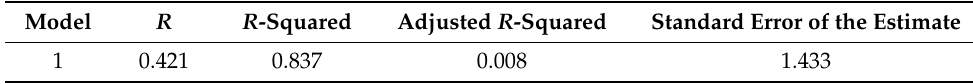
Table 3. Model summary for hypothesis